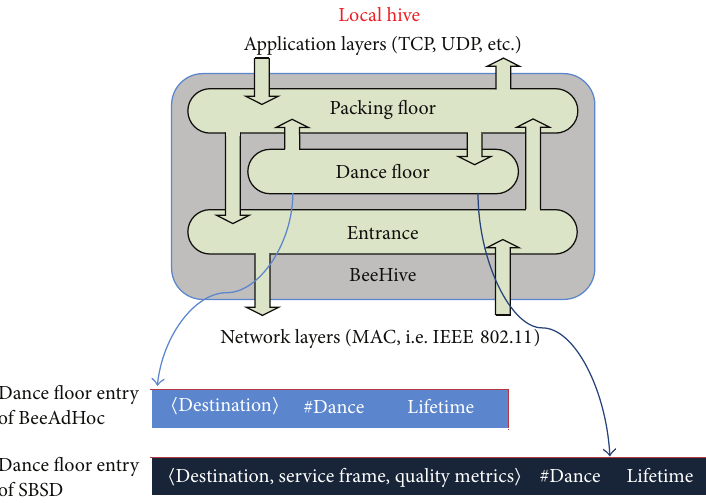
Figure 2: The network layer architecture of BeeAdHoc